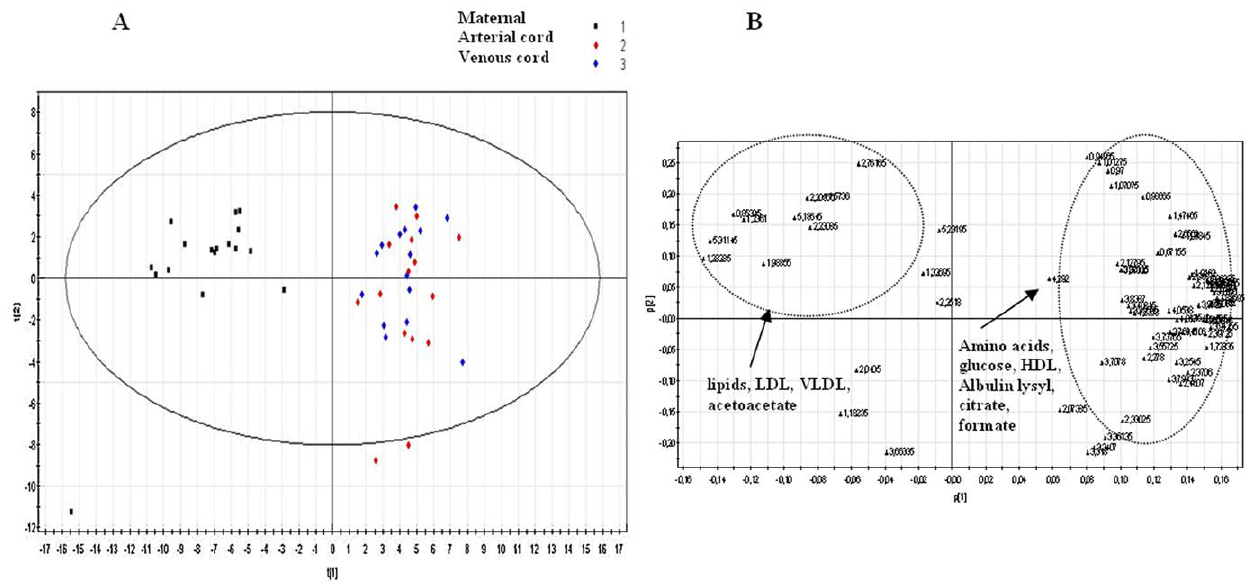
Figure 2. Multivariate analyses resulting from the 48 standard 1D spectra of maternal and both venous and arterial cord plasma from FT and VLBL deliveries. (A): PCA scores plot. (B): PCA loadings plot. The maternal plasma and both venous and arterial cord plasma are clearly distinguished on the first component which accounts for 54% of the total variance. The second component, which account for 14% of the total variance is related to inter-individual differences.